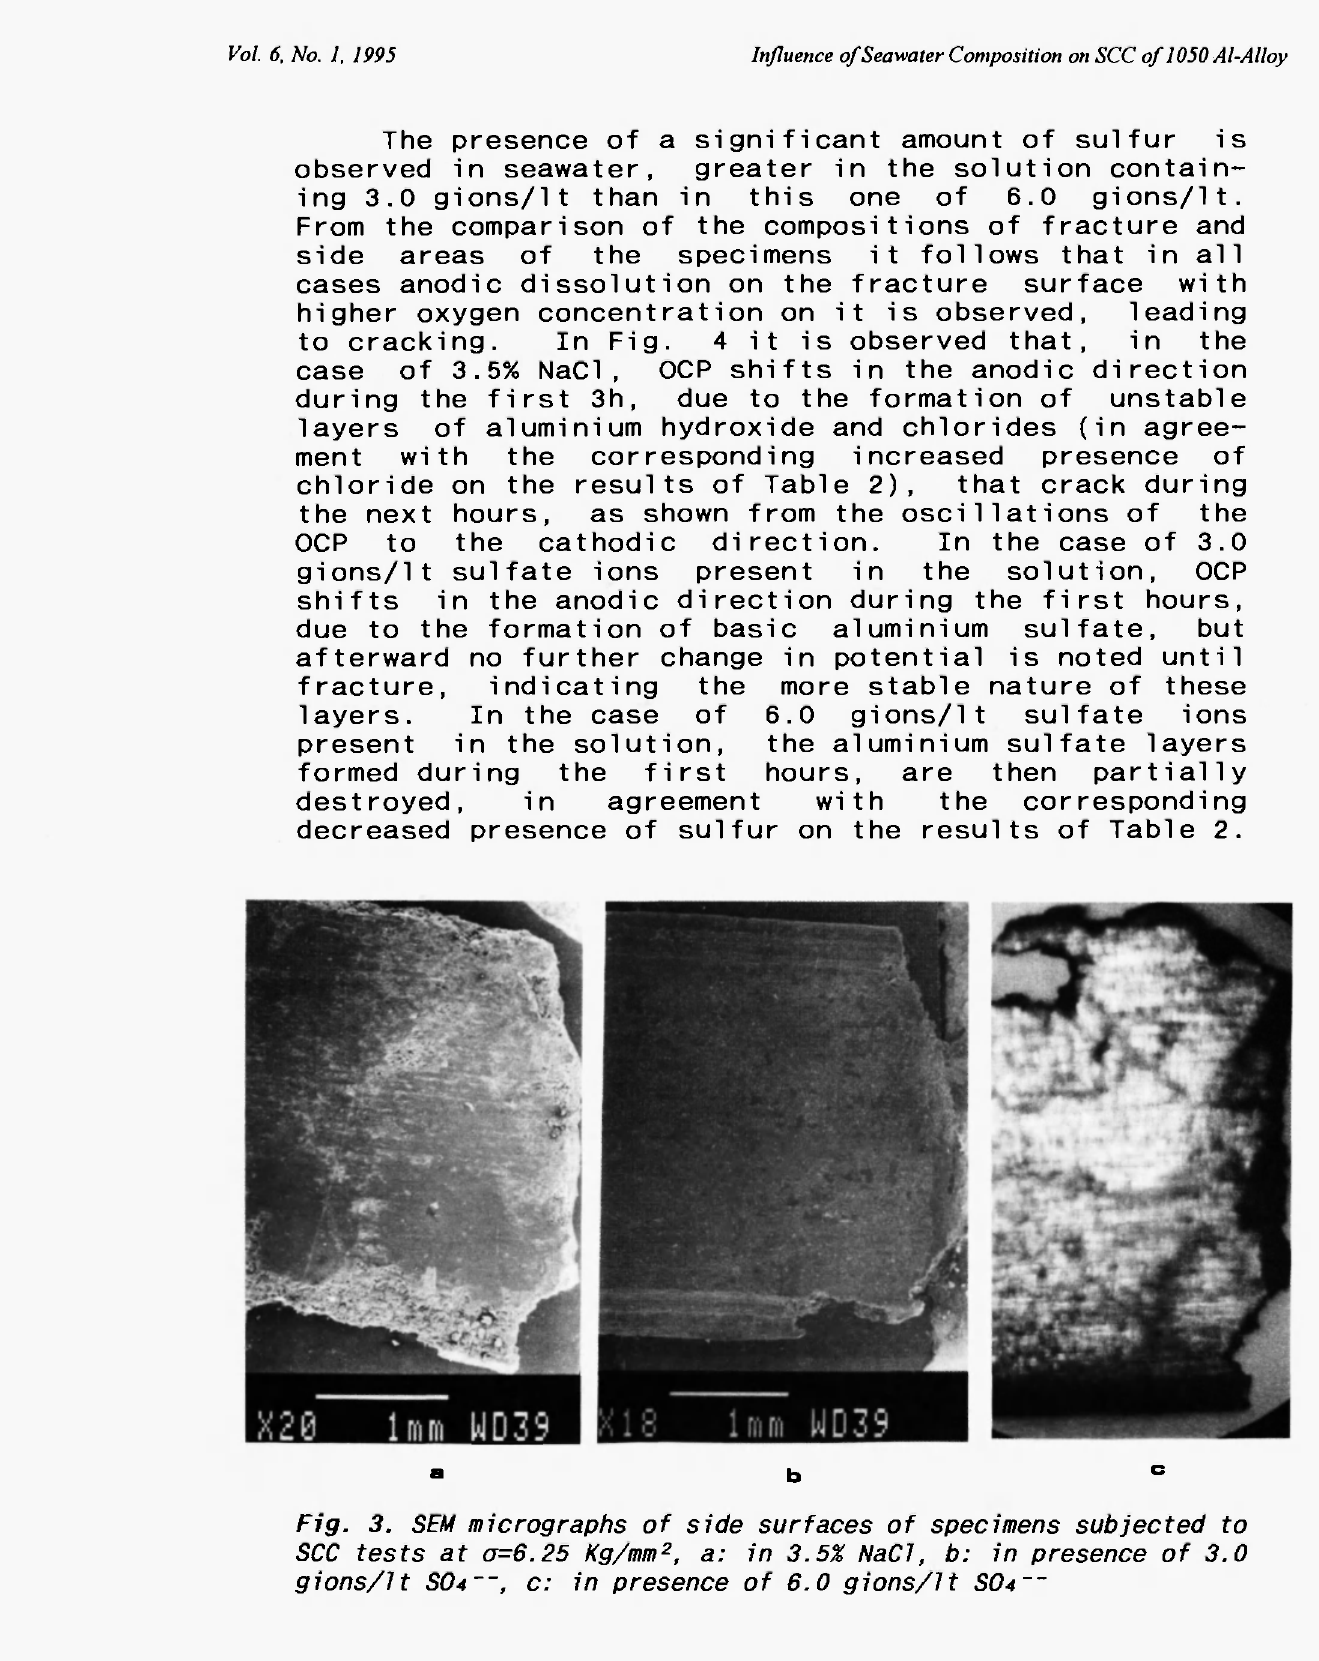
Fig. 3. SEM micrographs of side surfaces of specimens subjected to SCC tests at σ=6.25 Kg/mm 2 , a: in 3.5% NaCl, b: in presence of 3.0 gions/lt S04", c: in presence of 6.0 gions/lt